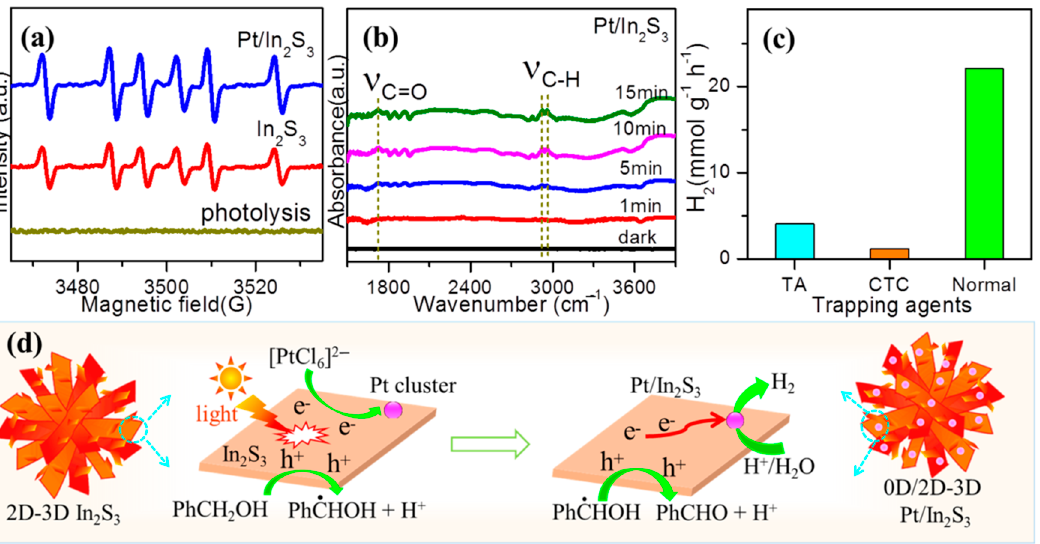
Figure 8. ( a ) EPR spectra of DMPO-CH(OH)Ph over different photocatalysts. ( b ) In situ DRIFTS spectra of the 0.3% Pt/In 2 S 3 hybrid with the existence of PhCH 2 OH under simulated sunlight. ( c ) The effect of the trapping agents on the PHP over the 0.3% Pt/In 2 S 3 hybrid. ( d ) Illustration of the formation and photocatalytic mechanism of the 0D/2D-3D Pt/In 2 S 3 heterostructure.